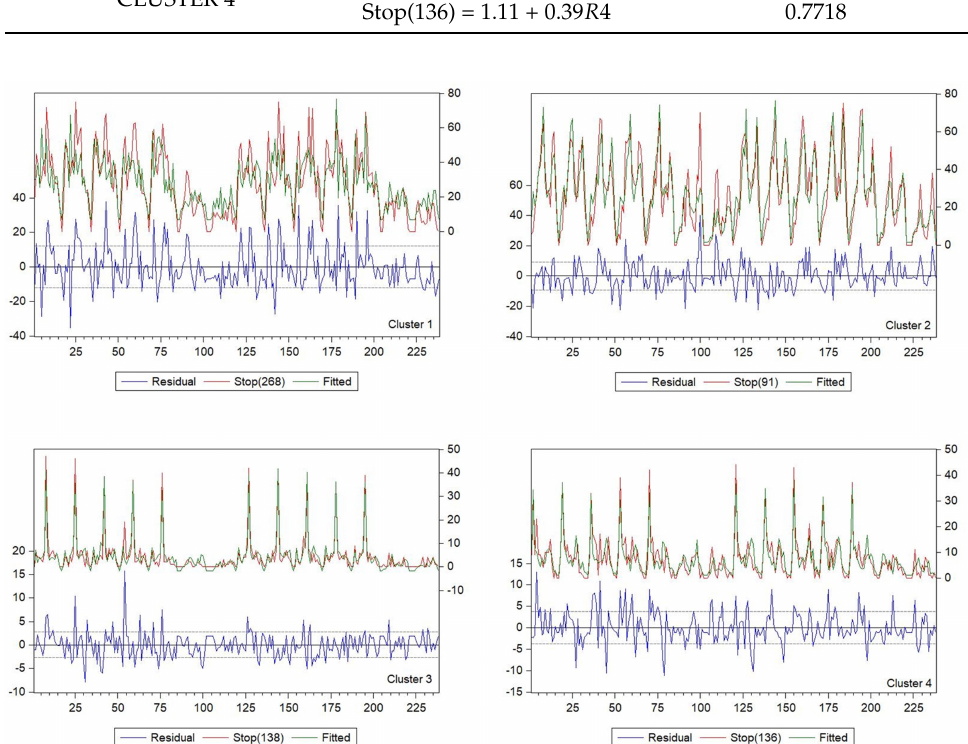
Figure 16. Fitted values from cointegration equations for one stop in each cluster, together with the real values and the residuals of the